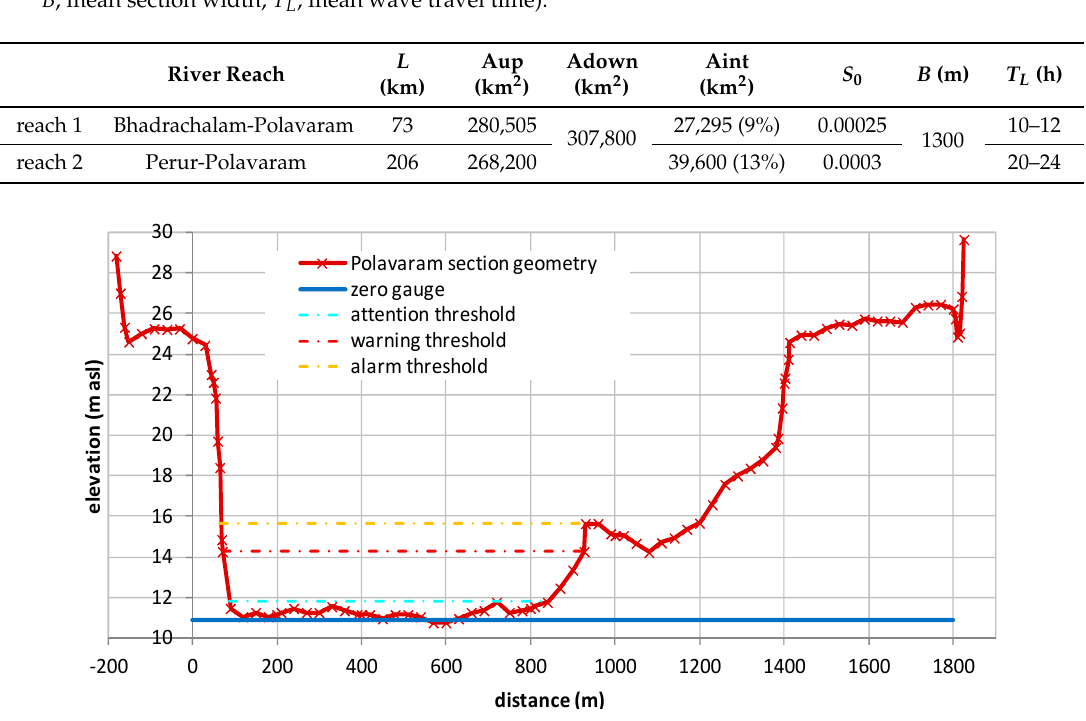
Figure 3. Godavari River: geometry of the Polavaram section where the stage forecast and the PU estimate are provided. The zero gauge level is shown along with the assumed hydrometric thresholds.